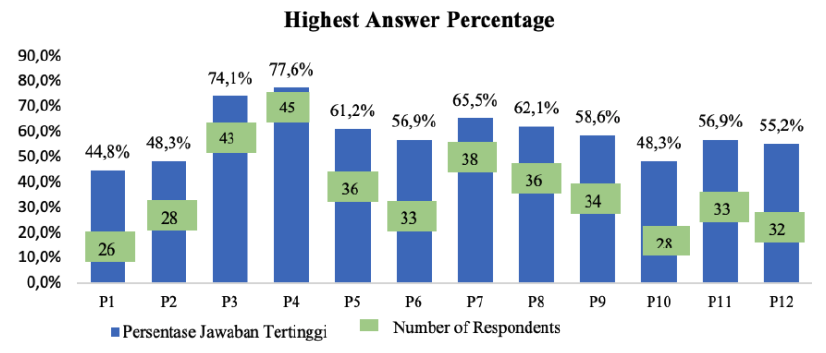
Figure 3: Percentage of Programs Required by